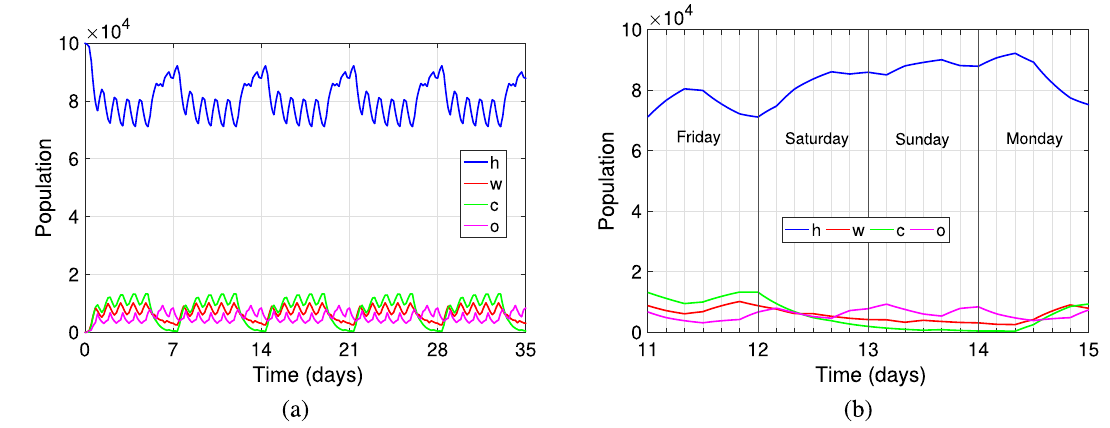
Figure 1. Daily distribution of the population in the spatial compartments of h -home, w -work, c -educational facilities, and o -other activities. In ( a ) the dynamics for five consecutive weeks. In ( b ) the dynamics during 4 days from Friday to Monday to differentiate workday and weekend, depicting within each day six time-blocks. The parameters involved are detailed in Table 1 with a total population size N = 100,000 .